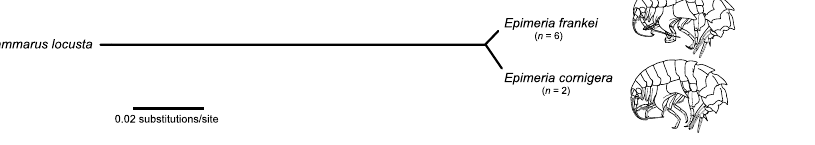
Figure 3. Unrooted Neighbour-joining phylogram of the complete 18S rRNA genes of Epimeria cornigera , Epimeria frankei sp. nov., and Gammarus locusta based on patristic distances.